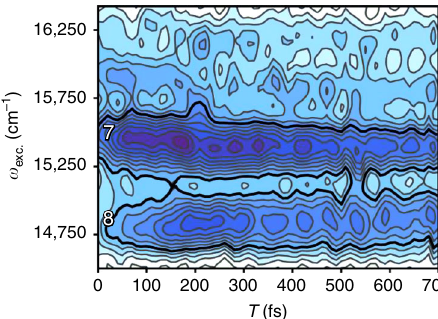
Fig. 6 Spectral modulation along the excitation axis. Spectral evolution along the excitation axis through excited state absorptions seven and eight, at a detection frequency of 1590 cm − 1 , plotted as a function of waiting time. The colormap used here is identical to that in Fig.